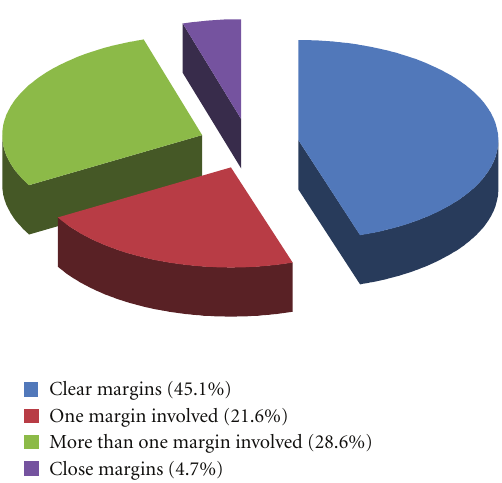
Figure 1: Showing margin clearance for